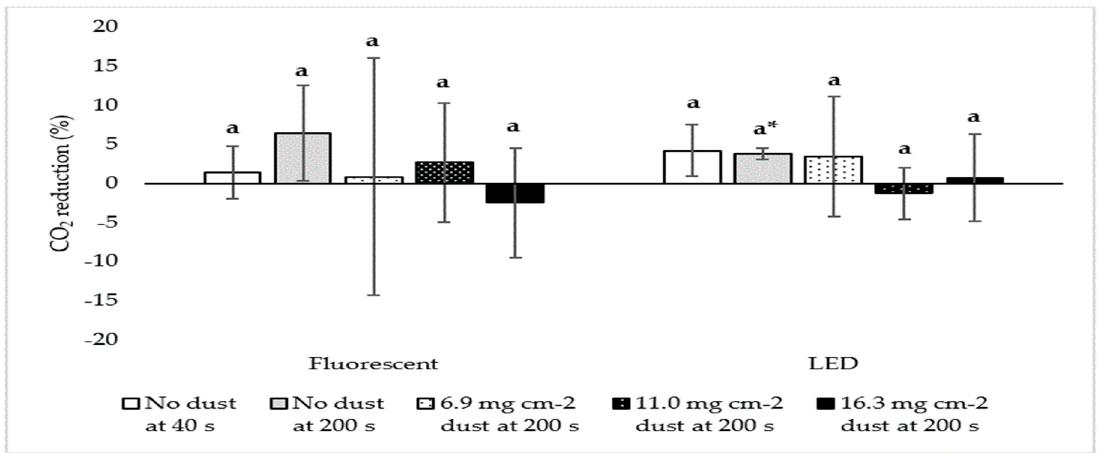
Figure 11. CO 2 mitigation under different poultry dust levels at 12% of relative humidity in photocatalysis. Superscript (*) signifies a statistical difference compared to the control ( p < 0.05), and the character (a) signifies there is no statistical difference under the two different treatment times ( p > 0.05). Error bars signify ± standard deviation.